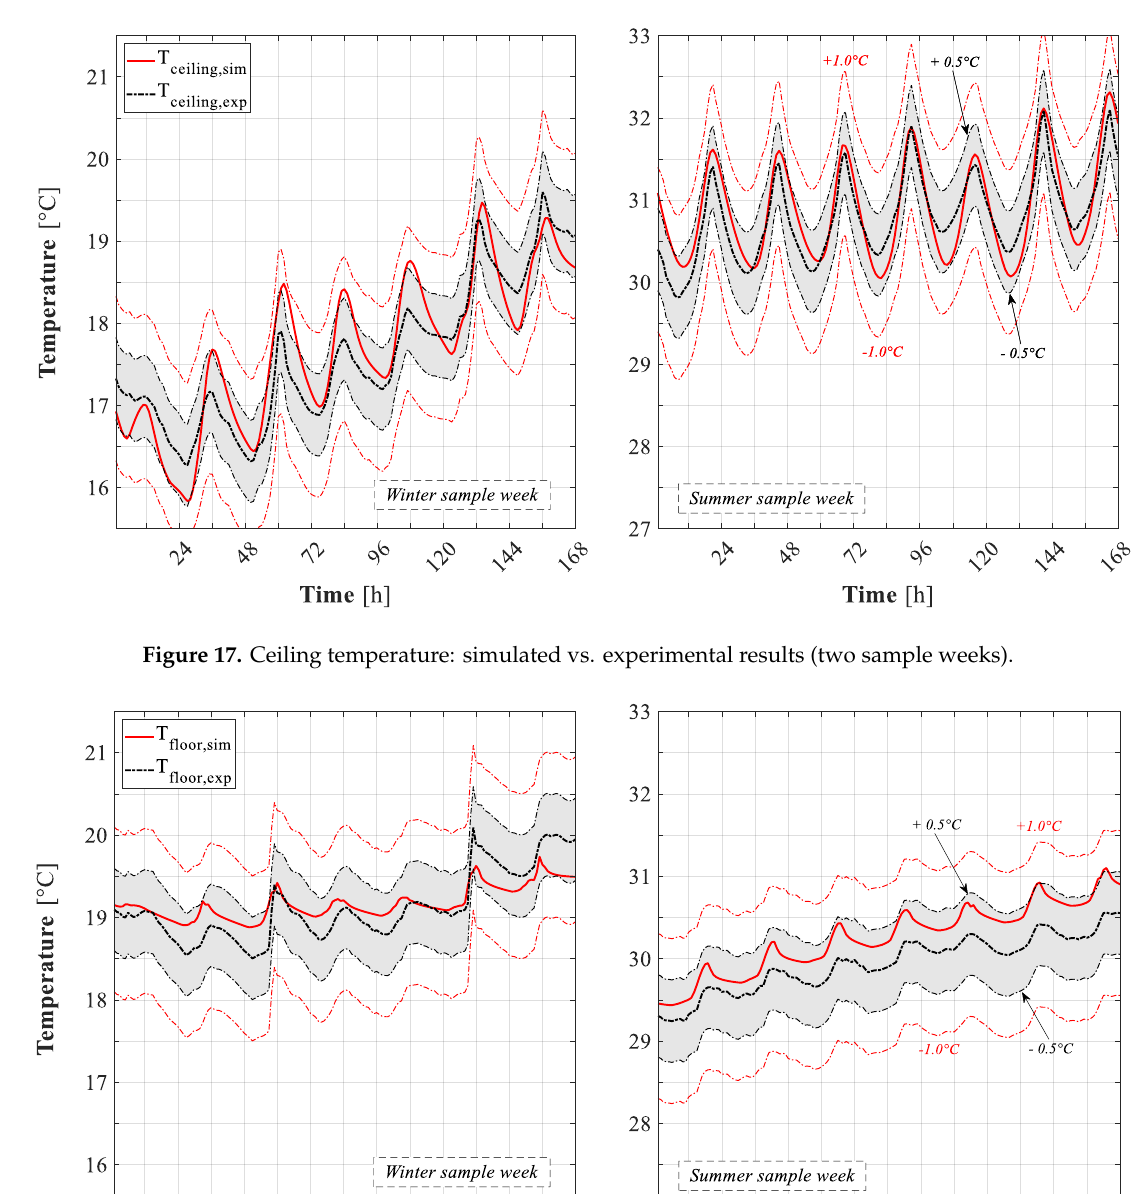
Figure 16. South-East wall temperature: simulated vs. experimental results (two sample weeks).